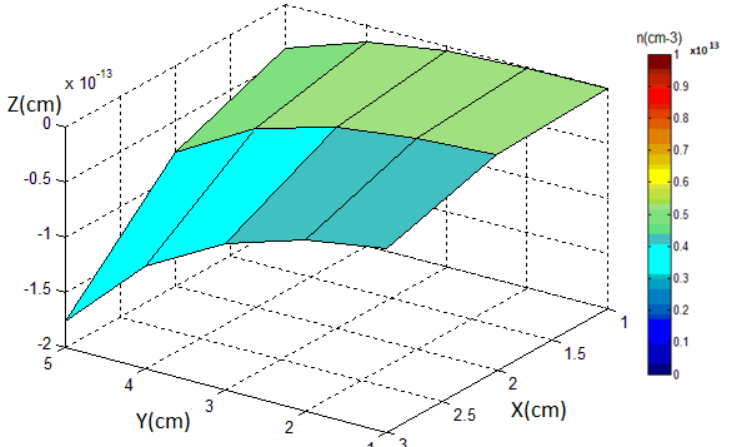
Figure 10: The spatial profile of electron number density of carbon laser induced plasma at